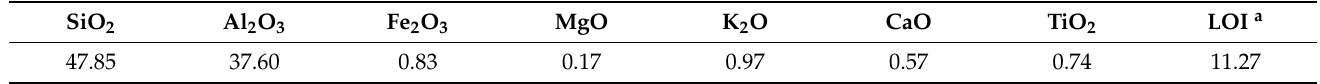
Table 1. Chemical composition of the used kaolin